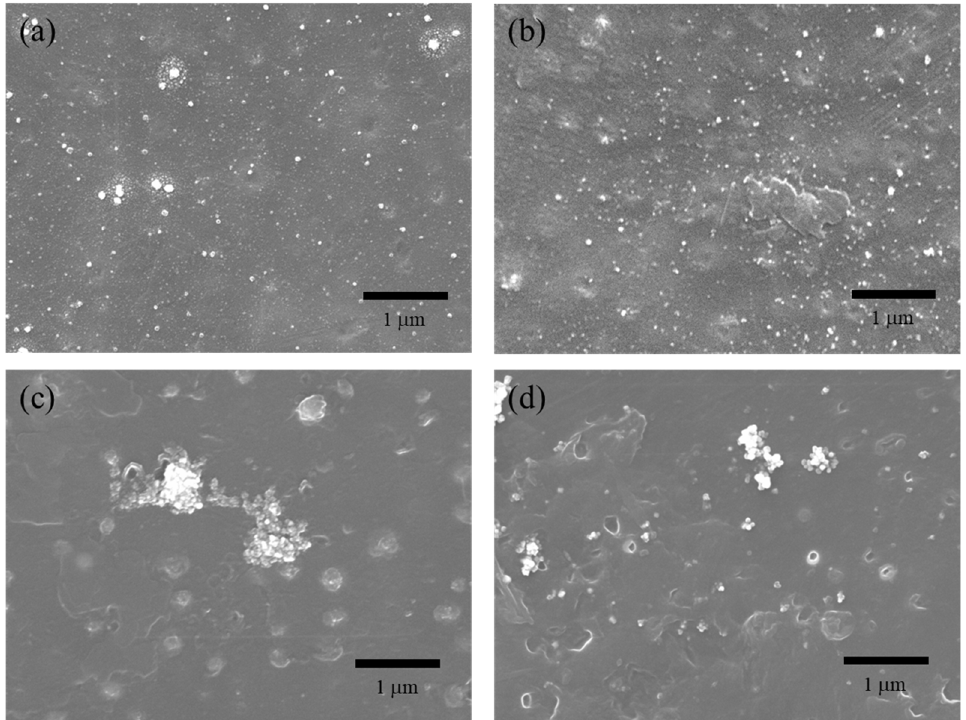
Figure 1. SEM images of Ag/ABS samples synthesized by using radiation. ( a ) Gamma ray, without 2-prop.; ( b ) Gamma ray, with 2-prop. (10% vol.); ( c ) Electron beam, without 2-prop.; ( d ) Electron beam with 2-prop (10% vol.).